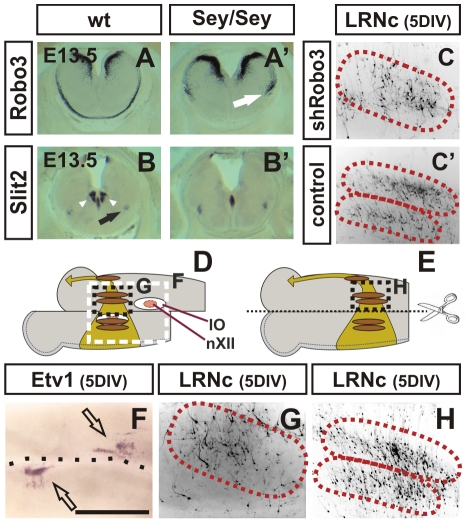
The Slit-Robo pathway controls the settlement of LRN neurons.(A,A′,B,B′) In situ hybridization of E13.5 coronal wt (A, B) and Pax6Sey/Sey (A′,B′) vibratome sections. The Slit receptor Robo3 is expressed in neurons at the basal and alar plate and in the mms (A). In Pax6Sey/Sey embryos basal and alar plate expression of Robo3 is identical to the wt expression (A′). However, Robo3 expression in the Pax6Sey/Sey
mms again demonstrates that mutant cells are delayed in midline crossing (white arrow in A′). In wt embryos Slit2 is expressed in a small group of cells at the midline, in the hypoglossal nuclei (arrowheads in B), in two small groups of cells at the site of the future LRN (black arrow in B), and at the ventricular zone of the rhombic lip. In Pax6Sey/Sey embryos the hypoglossal nuclei and therefore also the hypoglossal Slit2 expression are lost, whereas, other sites of Slit2 expression are unchanged (B′). shRNA driven knockdown of Robo3 results in a scattered LRN, suggesting that the Slit-Robo pathway controls the settling of LRN neurons (C). Control constructs had no effect on the LRNc (C′). To determine whether a local or a longitudinal distribution of guidance cues regulates the settling of LRN neurons into two sub-nuclei transplantation experiments were performed. After electroporation brainstem cultures were cut along the midline and the contralateral side was shifted to a posterior direction (D). The positions of the inferior olive (IO) and the hypoglossal nuclei (nXII) are indicated. The extent of the shift was determined by Etv1 in situ hybridization which specifically labels IO neurons (open arrows in F). (G) In a typical experiment in which the shift was larger than 500 µm neurons settled randomly in the contralateral LRN, suggesting, that cues close to the inferior olive, e.g. the hypoglossal nuclei, serve for the correct guidance of LRNc neurons. In control experiments in which there was no shift (E), LRNc neurons settled in a wt pattern and formed two groups of neurons (H). (Scale bar is 1.3 mm in [A,A′,B,B′]; 0,7 mm in [C,C′]; 0.6 mm in [F]; 0.44 mm in [G,H].)